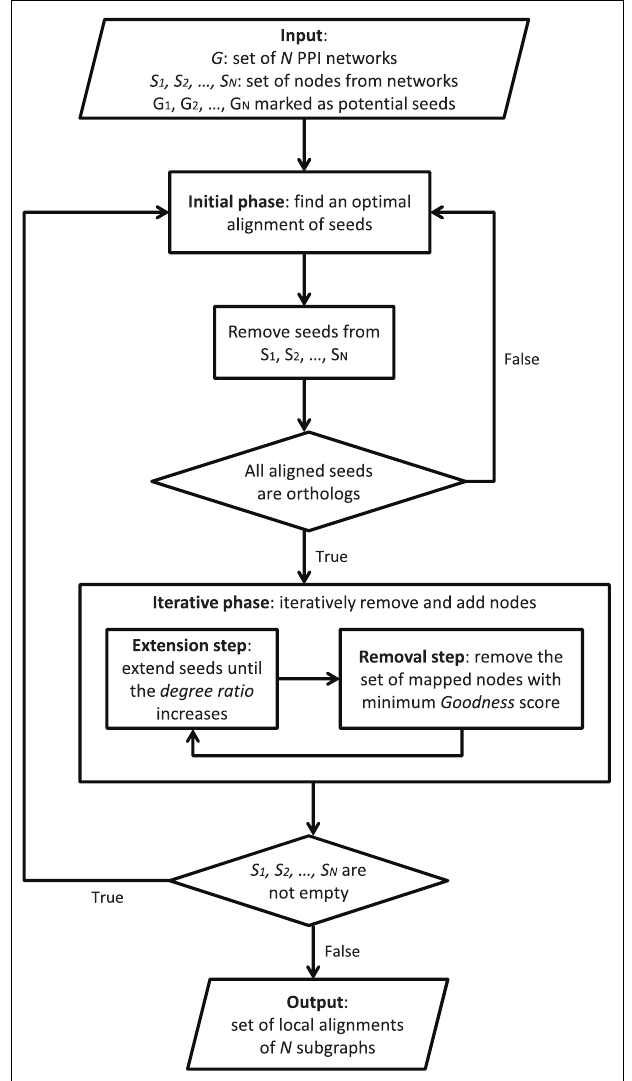
FIGURE 4 | General description of GASOLINE